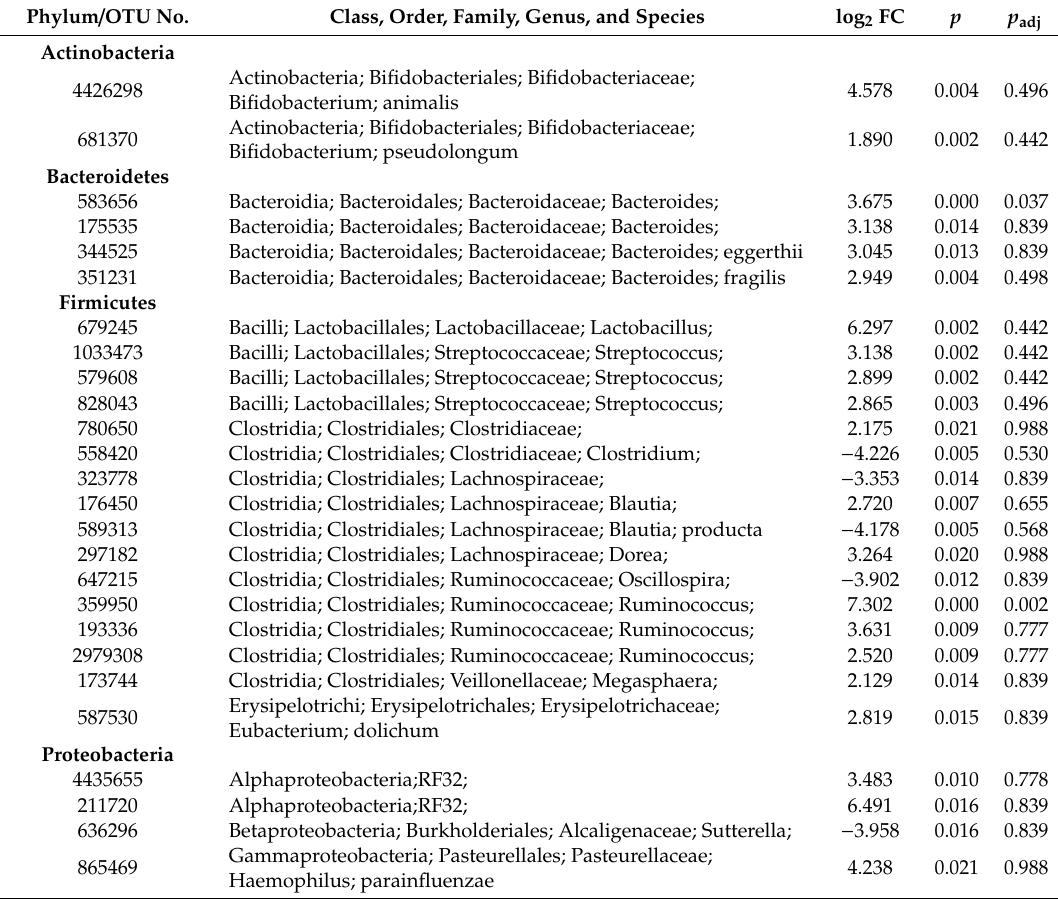
Table 2. Log 2 fold changes (FC) for operational taxonomic units (OTUs) with di ff erential abundance between the spice and placebo groups from baseline to 2 weeks.